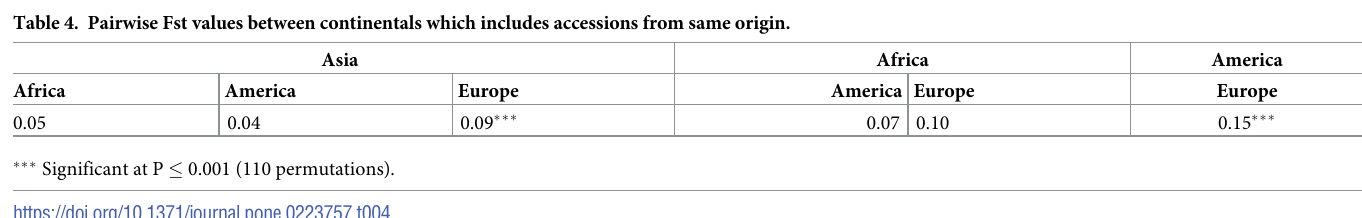
Table 4. Pairwise Fst values between continentals which includes accessions from same origin.